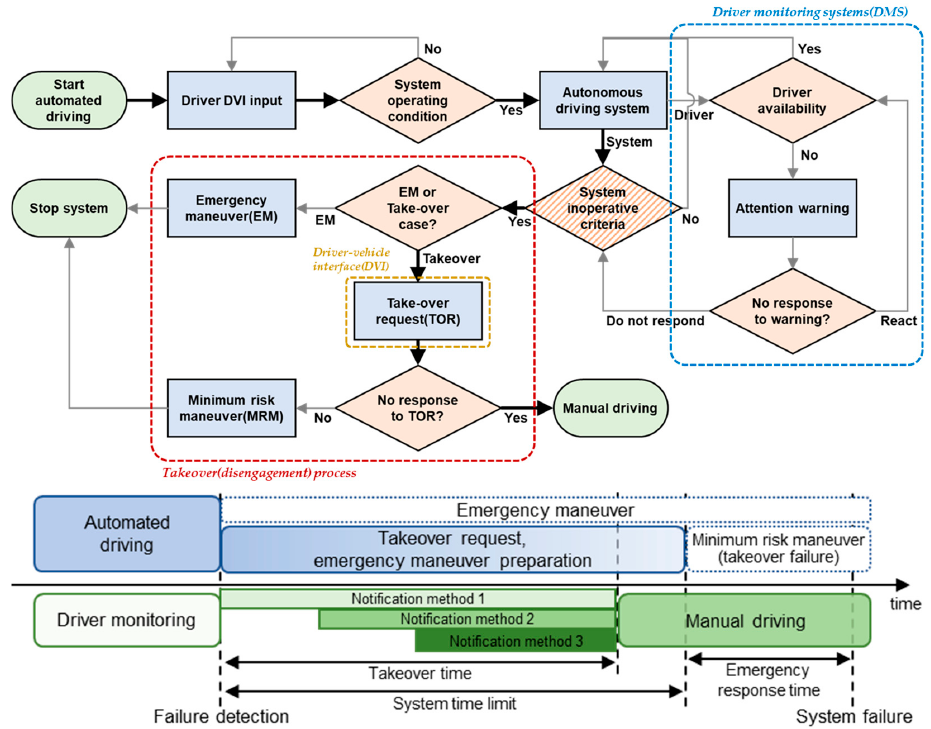
Figure 19. Takeover strategy of highly automated vehicle.